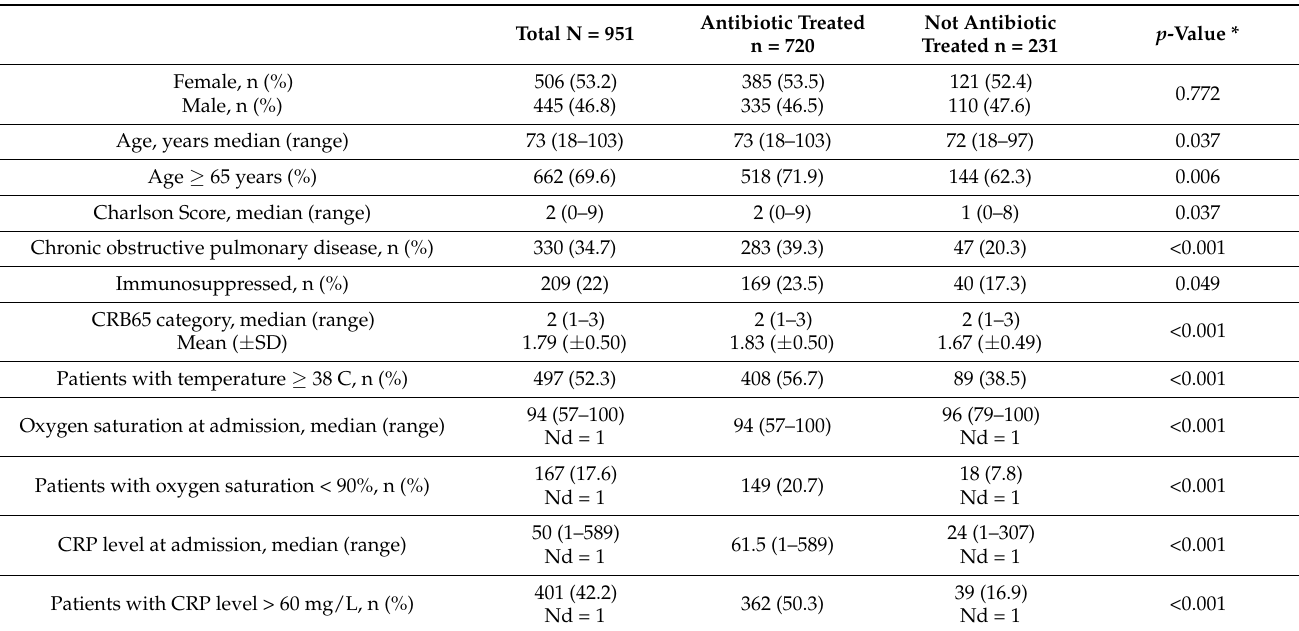
Table 1. Demographic data, medical status at admission and clinical outcome in 951 hospitalizations due to viral RTIs according to antibiotic treatment status.